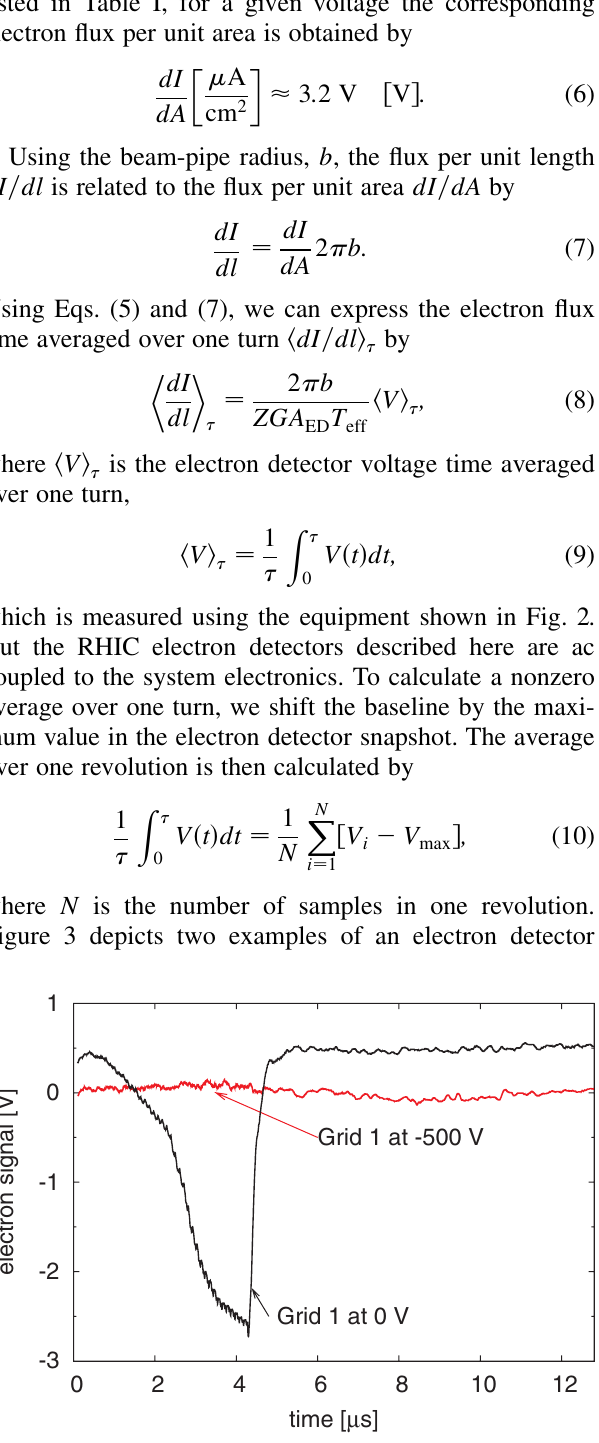
FIG. 3. (Color) Two electron detector snapshots of a RHIC revolution with 40 injected bunches spaced by 108 ns, and an (cid:4) 16 (cid:7) 10 10 protons. Without average bunch intensity of N b (cid:4) 0 V), an electron multipacting signal voltage at grid 1 ( V grid (cid:4) is observed (black trace). The signal disappears when V grid (cid:1) 500 V (red